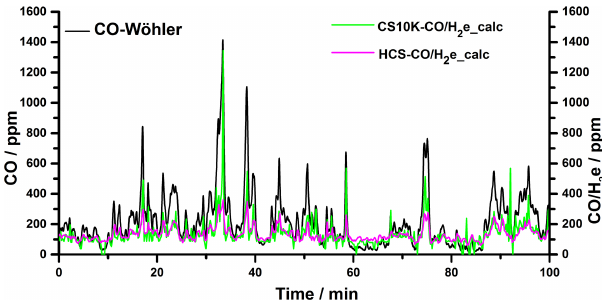
Figure 3. Representative cut-out of the CO / H 2 e concentrations of a CS10K and an HCS, as calculated from the calibration data, reg- istered together with the CO concentrations after a 4-month opera- tion sequence of the multi-fuel wood-chip-fired central heater under field test